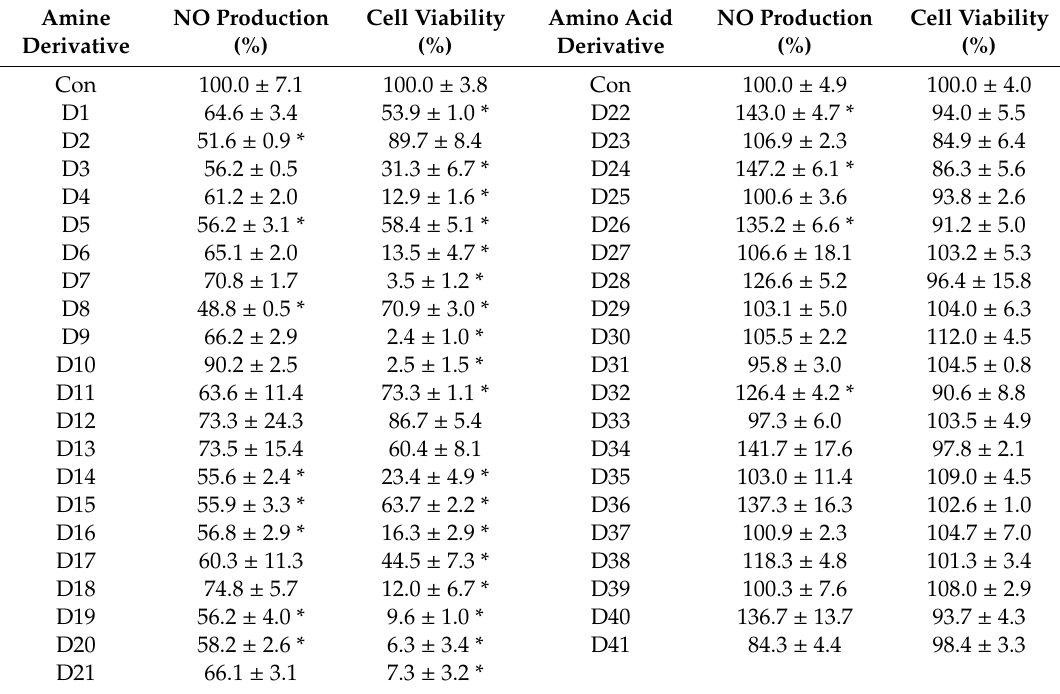
Table 2. Nitric oxide (NO) production and cell viability of amine and amino acid derivatives in Raw 264.7